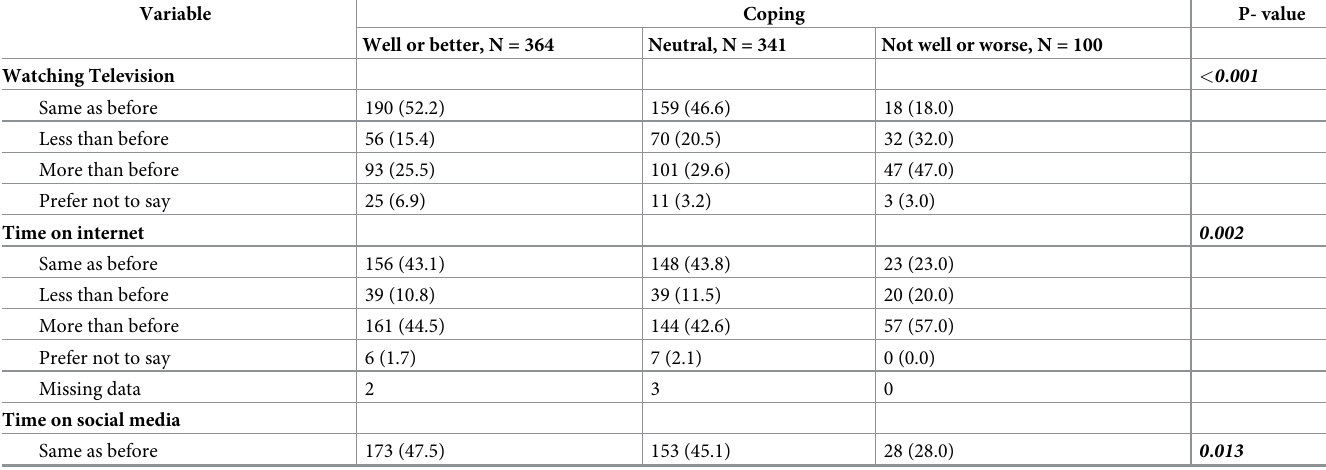
Table 6. Association between coping and levels of engagement in various activities during and ‘before’ the COVID-19 pandemic by participants.